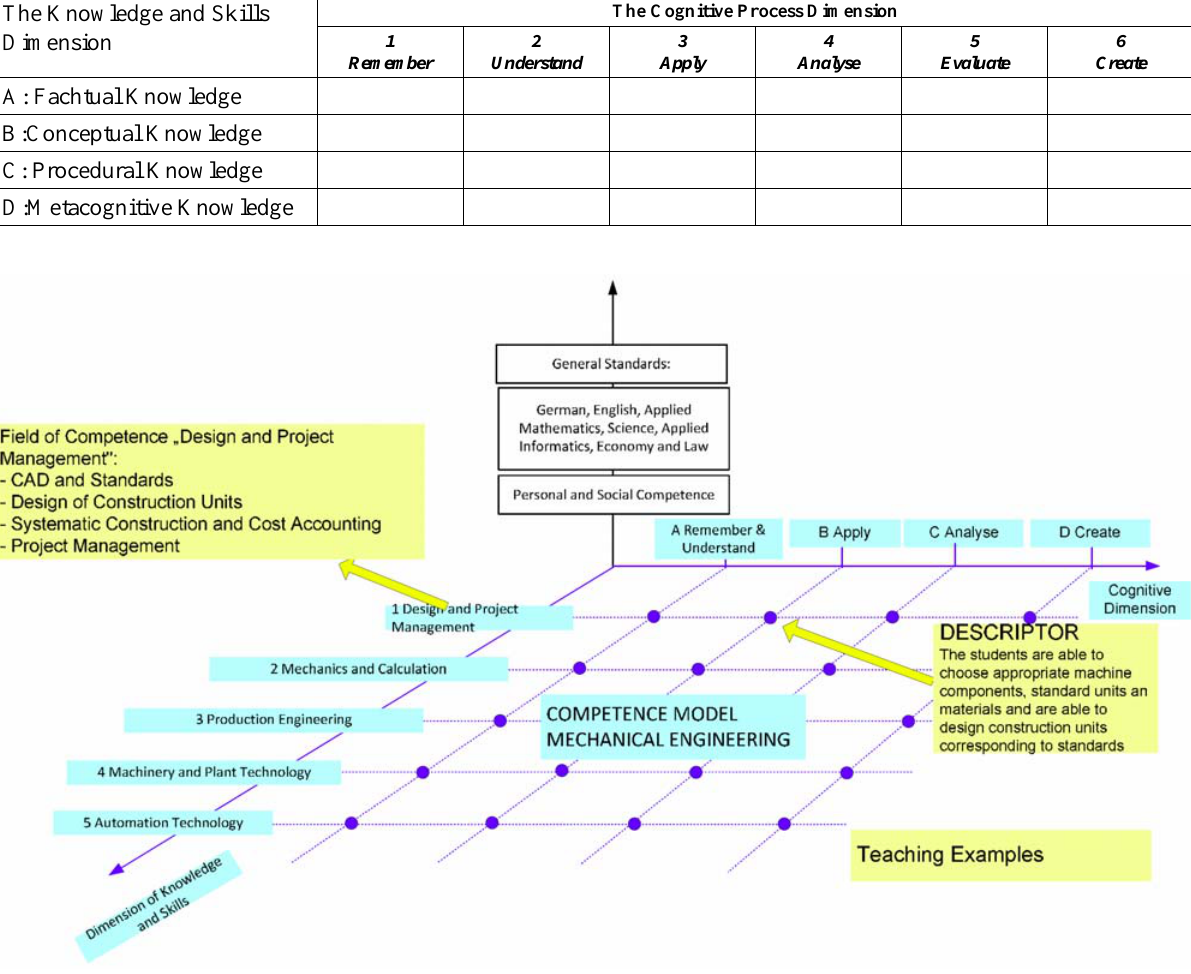
TABLE III. D ESCRIPTION OF E DUCATION S TANDARDS BY A NDERSON AND K RATWOHL